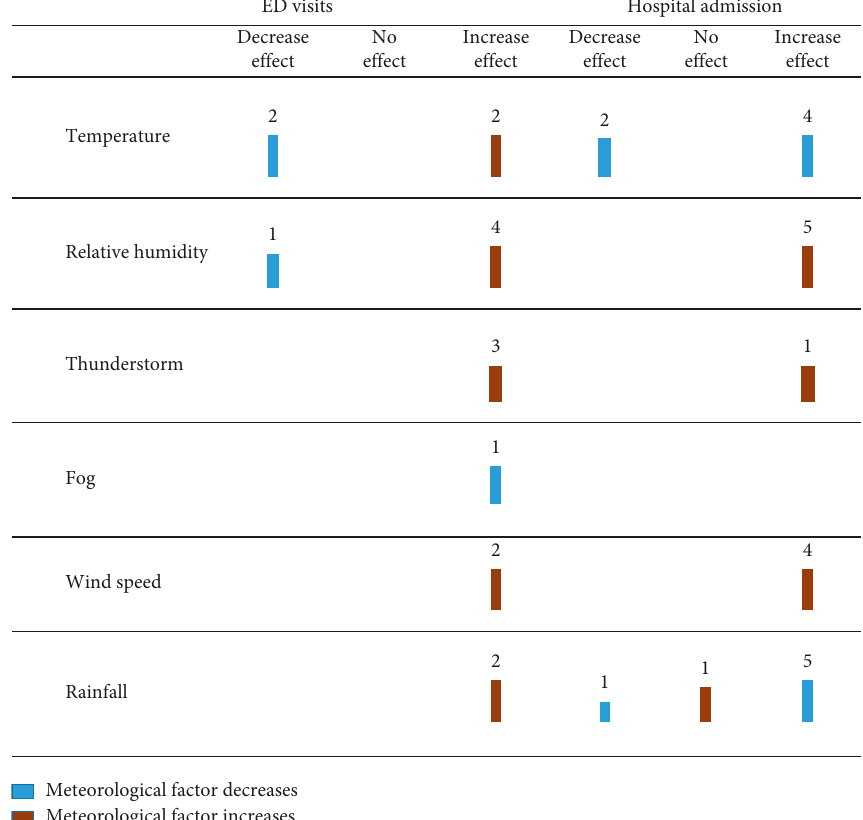
Figure 2: Evidence for the effect of meteorological factors on hospitalization and EDVs among adults with asthma. The rows indicate the all meteorological variables that affect asthma-related admission which are studied in the literature, and three columns shows different effects of each exposure. The numbers on the top of each bar indicate the number of studies that investigate the effect of that variable and find the result. The length of each bar shows the quality (good, fair, and poor) of the studies. The colors of each indicate the increase or decrease effect of the variable.